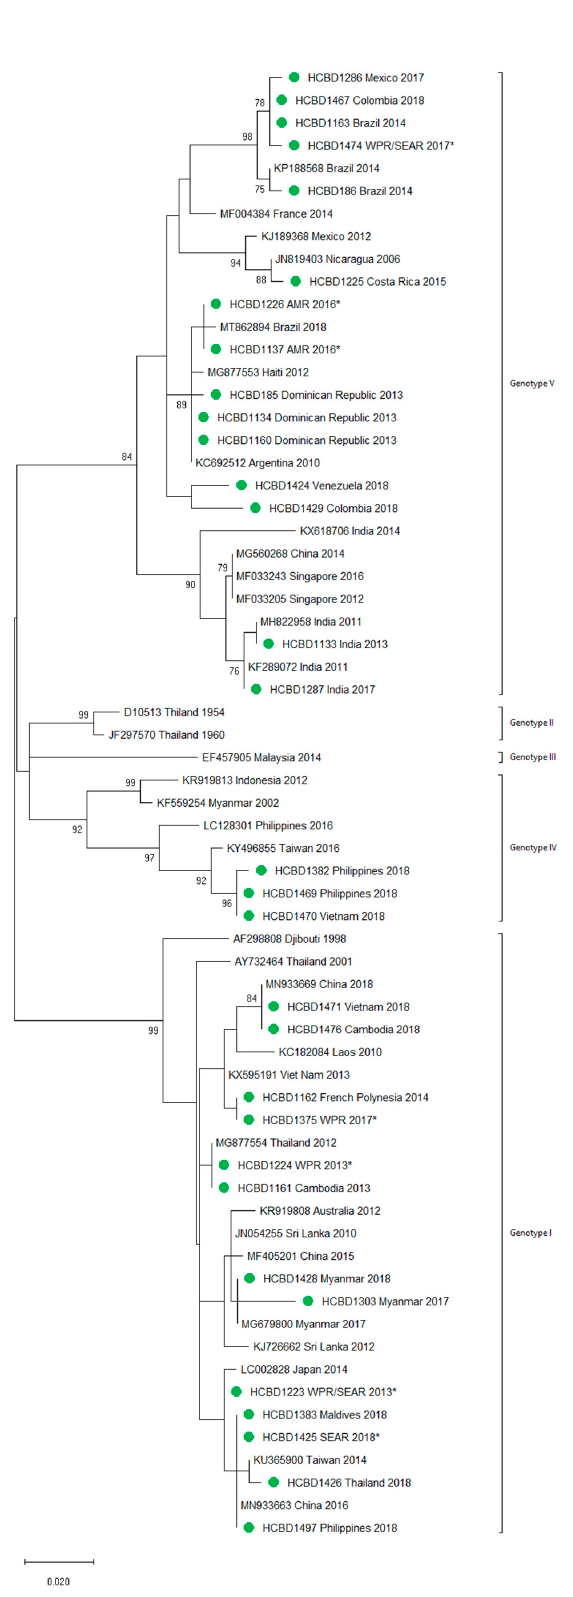
Figure 3. Phylogenetic tree of DENV-1 strains based on the E/NS1 junction region. Strains are denoted by the GenBank accession number, place and year of isolation. The green dots indicate the strains sequenced in this study and the scale bar indicates substitutions per site. The analysis was performed using the maximum likelihood method (K2 + G) with a bootstrap of 1000